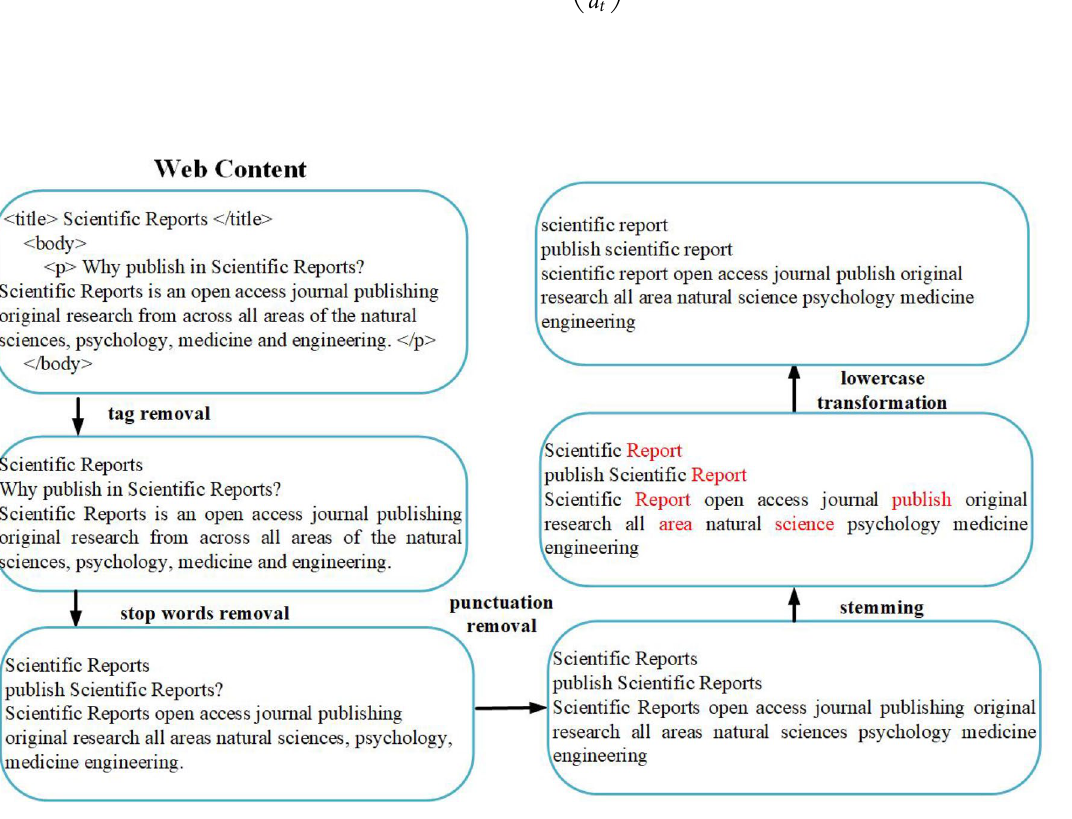
Figure 4. AJPC system preprocessing